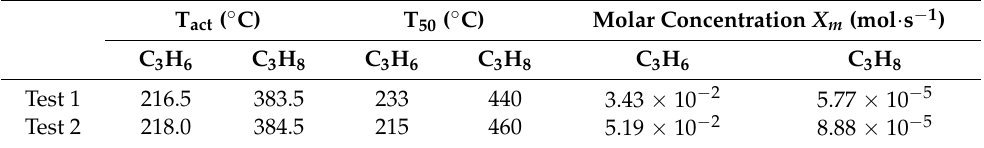
Table 4. Analysis of the results for SGBT.